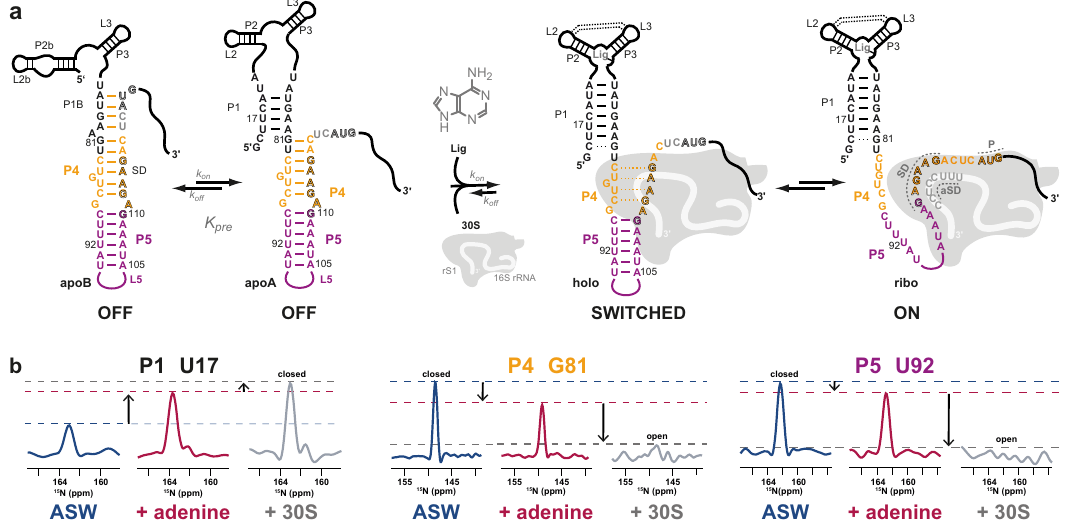
Fig. 1 Adenine-sensing riboswitch (ASW) regulating translation initiation in the context of adenine and 30S ribosome binding. a The two functional OFF-conformations apoB and apoA are in a temperature-dependent equilibrium linked through K pre. Adenine binding to the aptamer region leads to a compact structure with tertiary interactions such as the kissing loop interaction between L2 and L3. 30S ribosome binding to the standby site 3 ′ -terminal to the AUG start codon of the mRNA results in to melting of the Shine-Dalgarno (SD) sequence in helix P4 of the riboswitch (switched). Further, a stable SD- aSD interaction forms and the mRNA is incorporated into the mRNA tunnel when both P4 and P5 are opened. b 1D projections of the 15 N dimension of 2D [ 1 H- 15 N]-BEST-TROSY experiments at 25 °C shown for peaks in helices P1, P4 and P5 for ASW 14 – 140 without (apo, blue), with 1.4 eq. adenine (holo, magenta) and in complex with the ribosome (30S + holo,